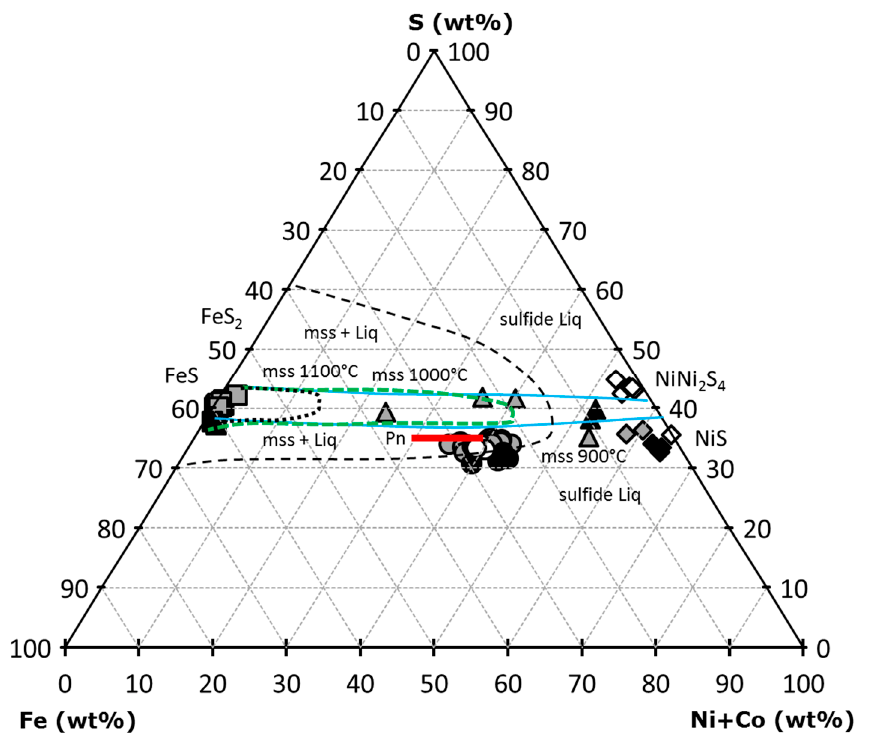
Figure 6. Composition of sulfides in the Fe-(Ni + Co)-S (wt%) system. The high-temperature (1100–900 °C) phase relations are after Killerud et al. [48]. The green dashed line borders a field where mss coexists with sulfide liquid at 1000 °C. The thin dashed line borders sulfide liquid field from that of mss + liq at 1000 °C (after Shindo et al. [13]). Empty symbols are for sulfides from Cpx-poor Spl lherzolites; grey symbols are for sulfides from Cpx-rich Spl lherzolites; solid symbols are for sulfides from Spl-Grt lherzolittes. Circles are for Pn, squares are for Po, triangles are for the mss, diamonds are for Pld and Mlr. Sulfides of the e- and i-types do not show significant compositional differences in this system. Pentlandite composition range is based on Alard et al. [17].